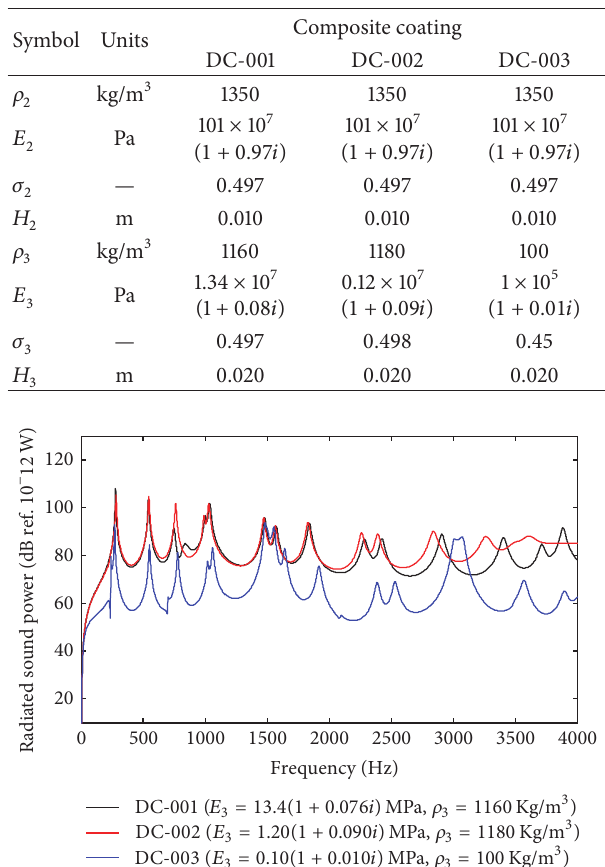
Table 1: Structural dimensions and material properties of the composite coating.